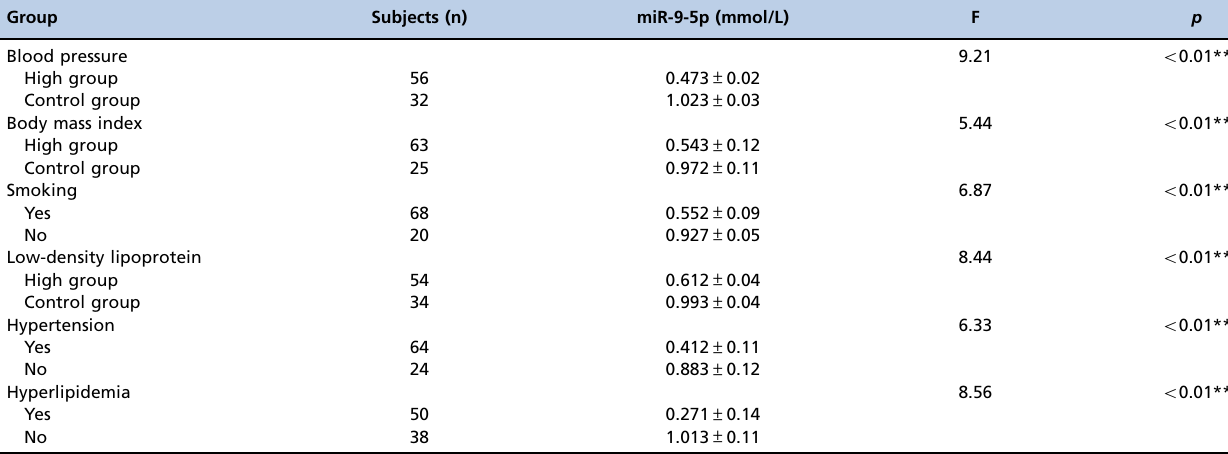
Table 2 - Hierarchical analysis of miR-9-5p. Group